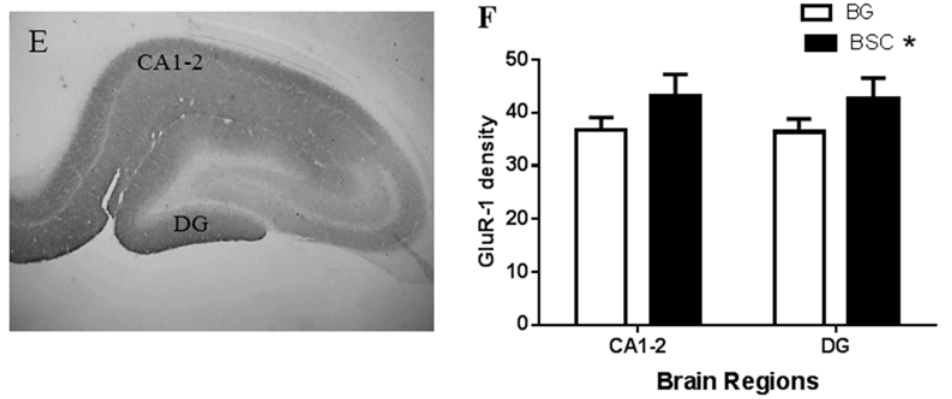
Figure 6. Analysis of the TH density (TH, A , B ) and the ChAT -positive neurons ( C , D ) in the striatum and the glutamate receptor-1 density in the hippocampus ( E , F ). The data are presented as mean ± SEM, n = 16, BG = blank gel, * p <